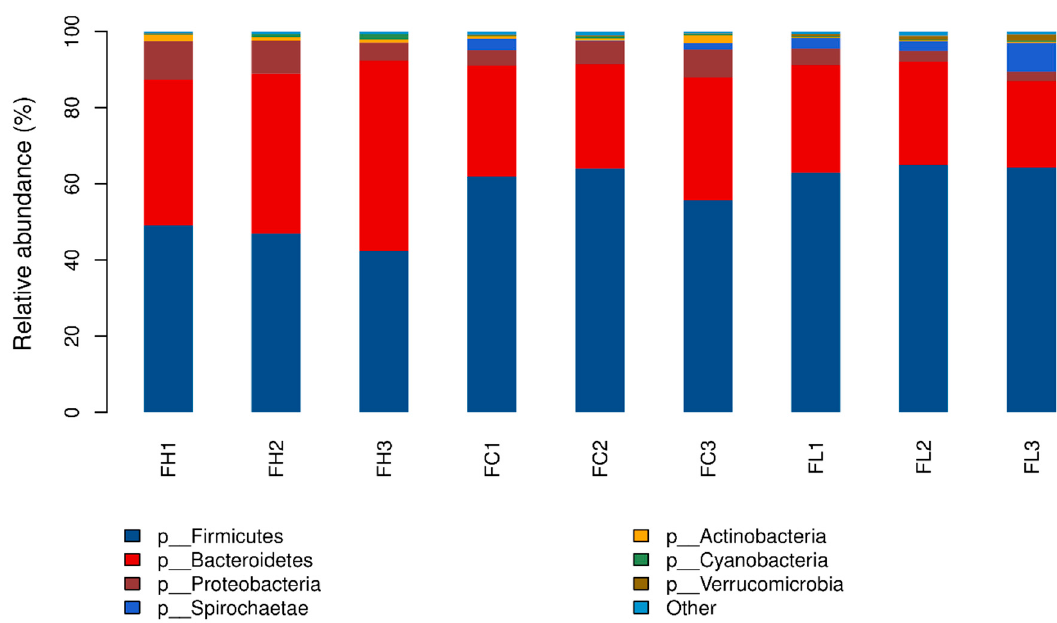
Figure 1. The relative abundance of fecal bacterial composition at the phylum level. FH, FC, and FL indicate stepwise high energy and protein diet group, standard energy and protein diet group, and low energy and protein diet group, respectively. Numbers 1–3 indicate phase 1, phase 2, and phase 3 of the fattening stage, respectively.